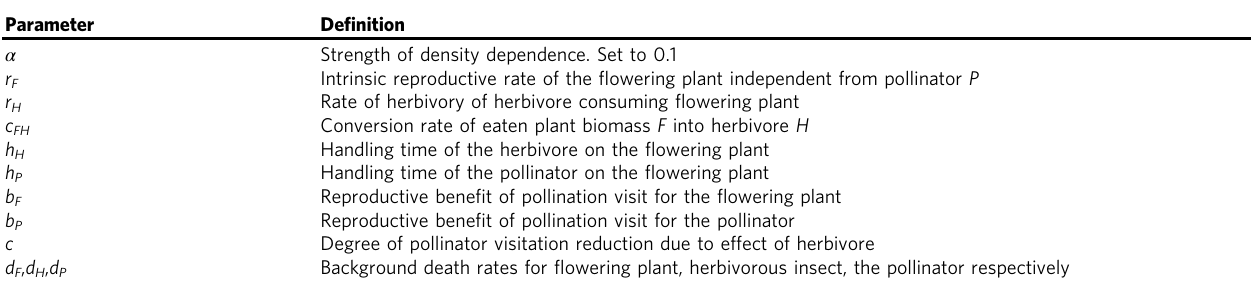
Table 1 Parameter de fi nitions for Equation 1 Parameter